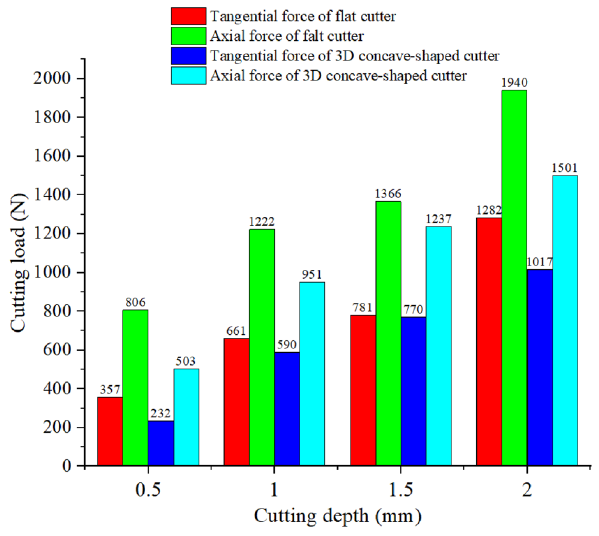
Fig. 12 Variation of cutting load with different cutting depths